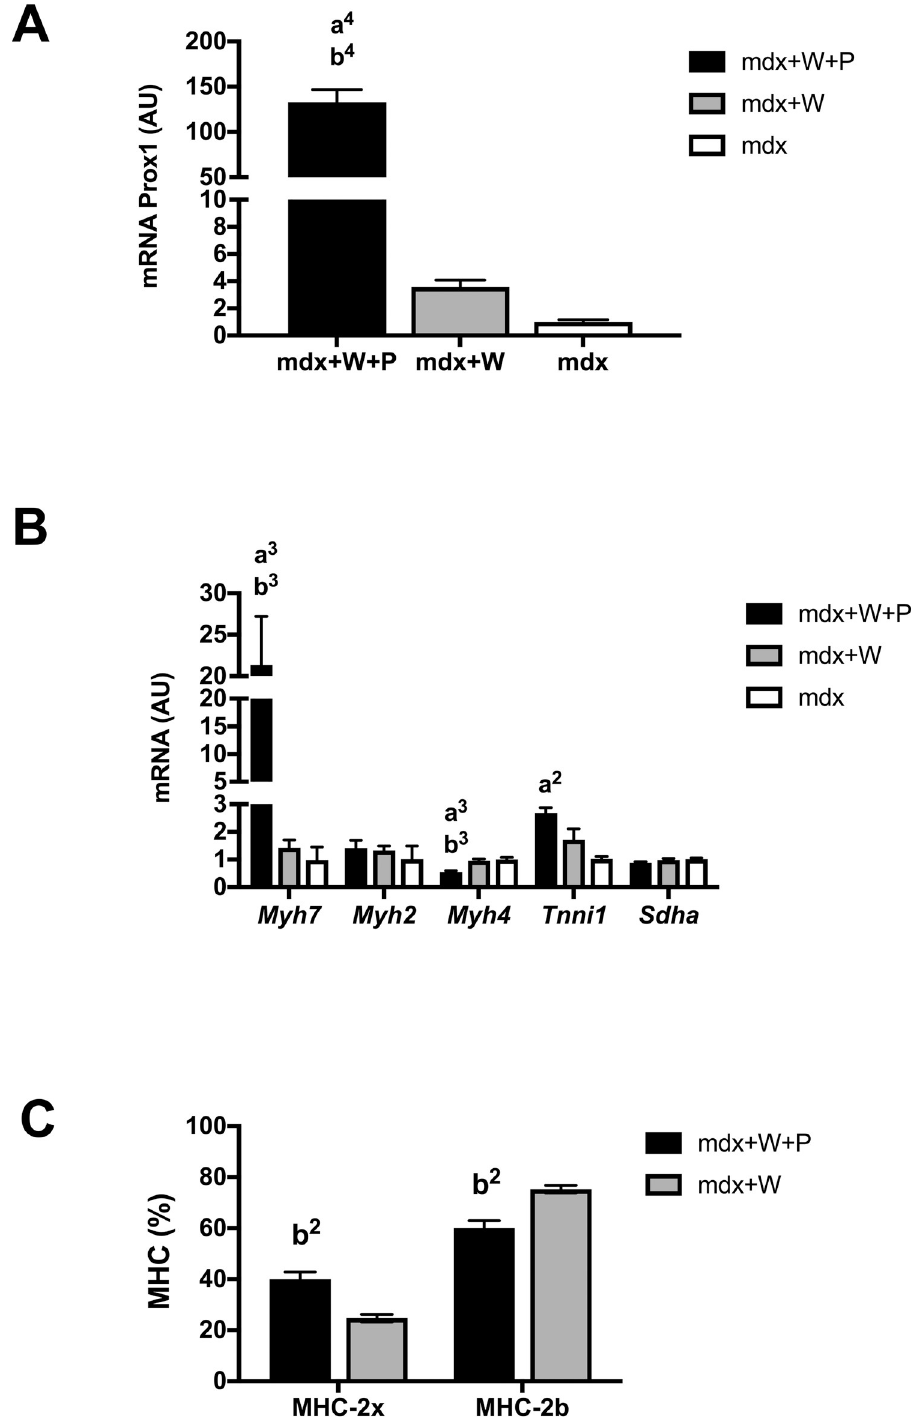
Fig 2. Effect of Prox1 transfer on the expression of Prox1 and markers of fibre type specification in voluntary exercised mdx mice (first set of experiment). (A) Prox1 expression in Mdx+W+P and Mdx+P muscle. N = 6–8 per group. (B) Expression of genes encoding fibre type specific contractile proteins in Mdx+W+P and Mdx+P muscle. N = 6–8 per group. (C) Relative amounts of MHC-2x and MHC-2b proteins in Mdx+W+P and Mdx+P muscle. N = 3 per group. Mdx+W+P: voluntary exercised mdx muscle that received Prox1 transfer into the muscle. Mdx+W: voluntary exercised mdx muscle. Mdx: mdx muscle. a2, a3, a4: significant different from Mdx, p < 0.01, p < 0.001, p < 0.0001, respectively. b2, b3, b4: significant different from Mdx+W, p < 0.01, p < 0.001, p < 0.0001, respectively.